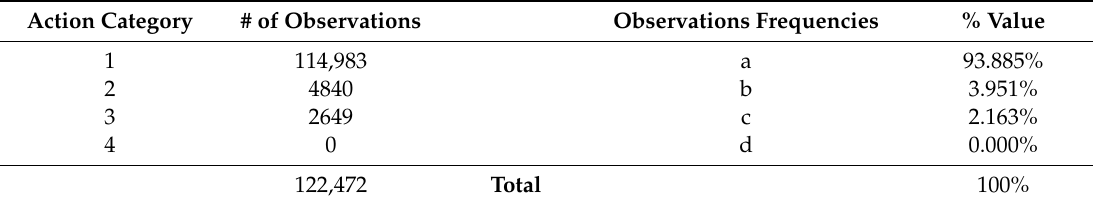
Table 7. Simulation results—OWAS coe ffi